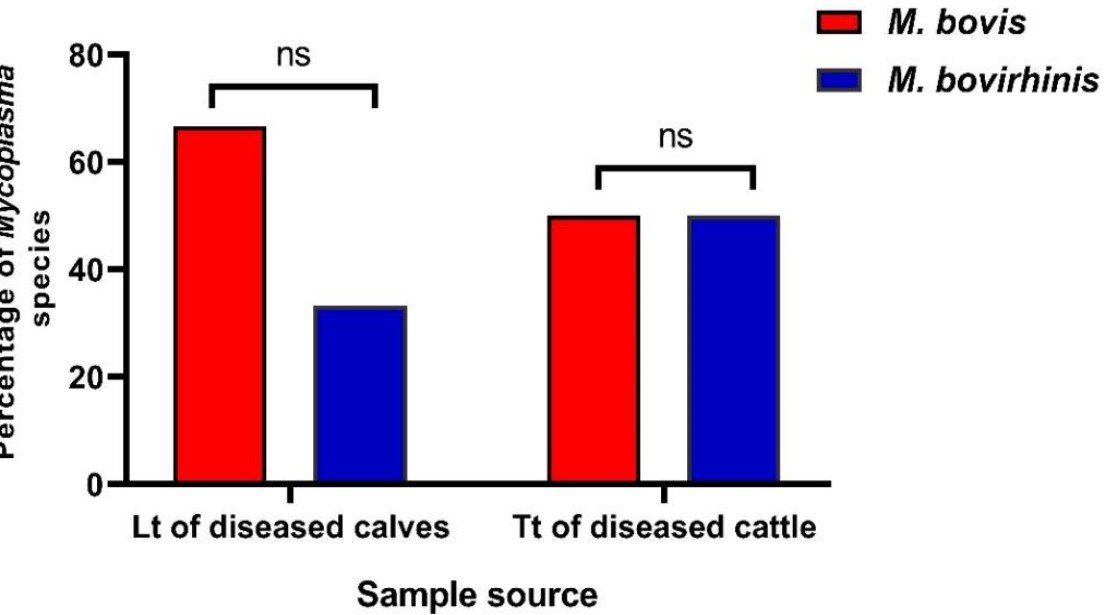
Figure 3. Prevalence of molecularly identified Mycoplasma species in the collected samples from different sources. The prevalence rate for each species was calculated regarding the total number of the examined samples from different sources. ns: non-significant, Lt: lung tissue, Tt: tracheal tissue. All molecularly confirmed mycoplasma isolates ( n = 5) were examined for the presence of gyrA and parC genes of the quinolone resistance-determining regions. All the tested isolates were positive for the gyrA gene (100%). Meanwhile, three isolates (60%) were positive for the parC gene; two M. bovis isolates were recovered from lung tissues of diseased calves, and the one remaining M. bovirhinis isolate was recovered from tracheal tissue of diseased cattle (Figure 4). Of note, the M. bovis isolate with the highest enrofloxacin